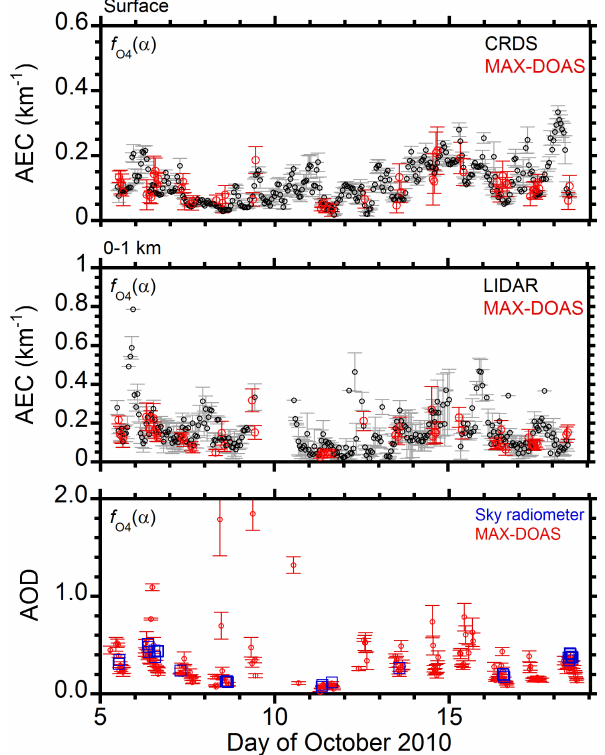
Figure 11. Same as Fig. 4, but f O in the MAX-DOAS